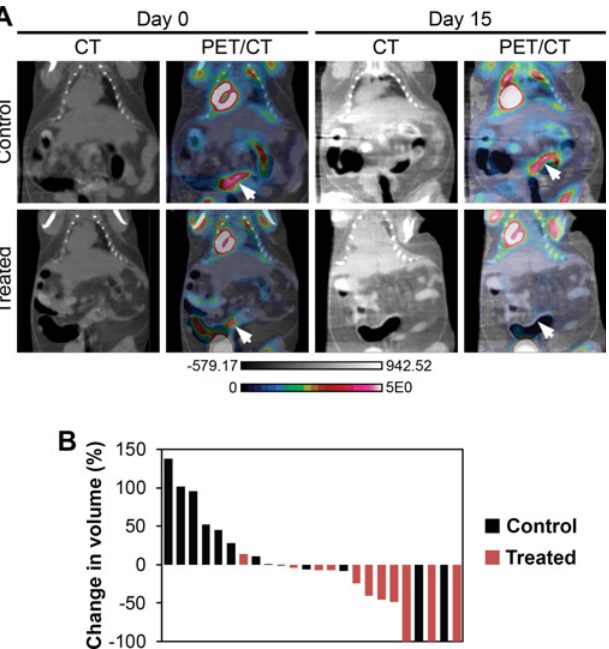
Fig 5. Dual PI3K/mTOR inhibition induces treatment responses in Fc + Pik3ca H1047R colon cancers. Fc + Pik3ca H1047R mice were treated with NVP-BEZ235 (35mg/kg/day) or control once daily by oral gavage for 14 days. These mice underwent dual hybrid 18F-FDG PET/CT imaging at baseline and then 24 hours following the last dose of study drug (A, arrows denote tumors pre- and post-treatment). A significant reduction in tumor volume, as measured on the CT images, was detected in the NVP-BEZ235 group (p = 0.008; B). In addition, there was a trend for a slight decrease in the median SUV for those cancers treated with the PI3K/mTOR inhibitor. In one control mouse, two tumors were observed on baseline imaging, but not detected on follow-up PET/CT imaging.